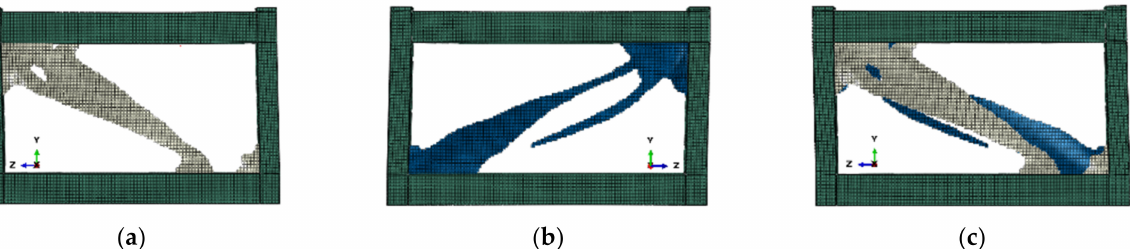
Figure 7. Nonlinear optimization results of SPSW with an aspect ratio of 0.5. ( a ) Front side. ( b ) Re- verse side. ( c ) Distribution of stiffening effect.